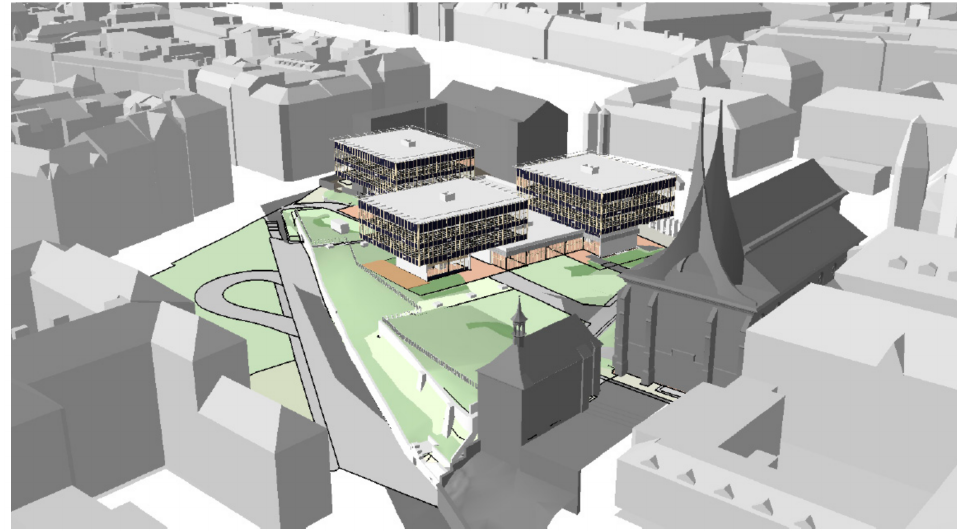
Figure 5. The combination of building information management (BIM) (the buildings in the middle) and GIS (the buildings from the 3Dmodel of Prague)